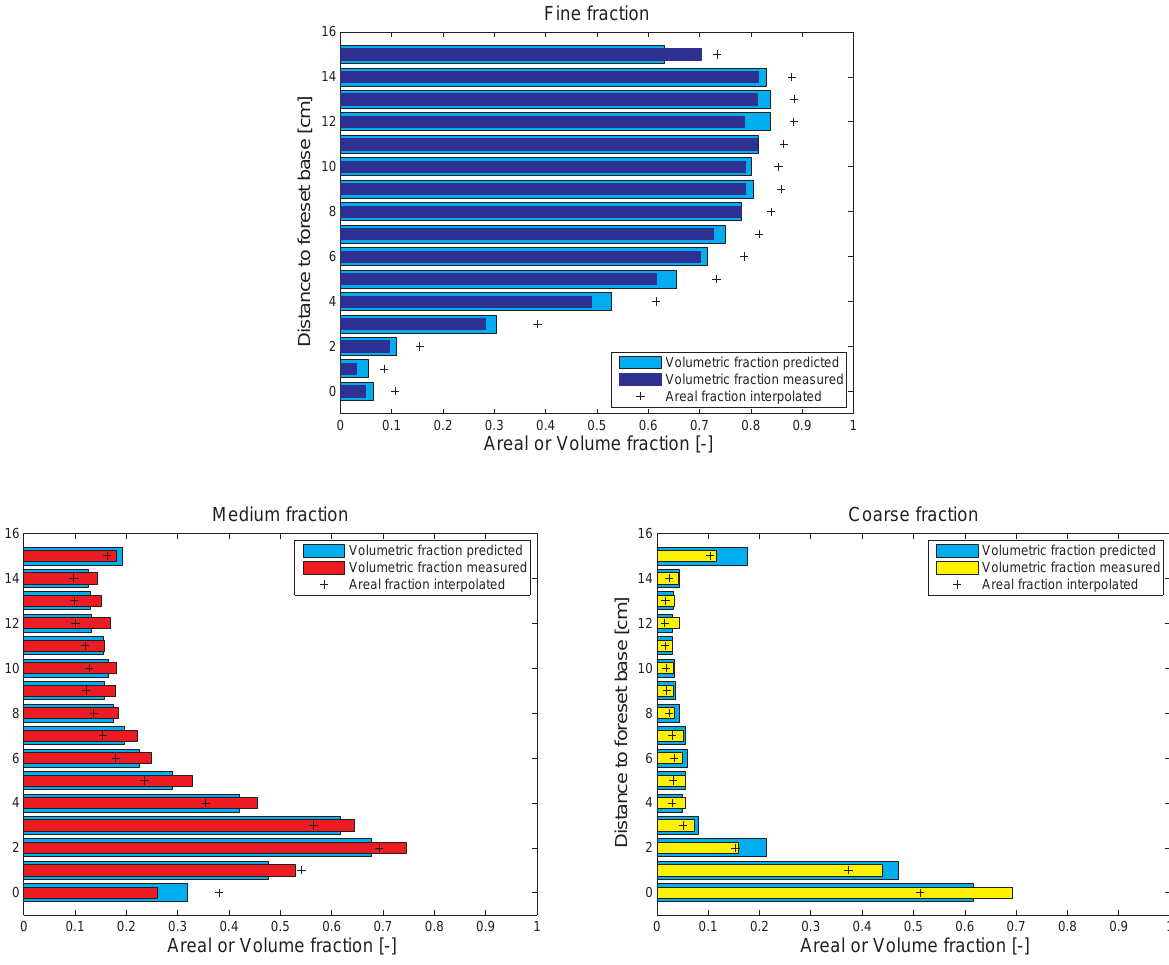
Figure 16. Vertical profiles of (1) the predicted volume fraction contents using Eq. (2), (2) the measured volume fraction contents measured through sieve analysis, (3) the areal fraction contents through image analysis for each grain-size fraction: (a) fine, (b) medium, and (c) coarse for Experiment 2, side sample. Note the areal fractions have been linearly interpolated. The crosses are now located at the elevation corresponding to the middle of the layer.